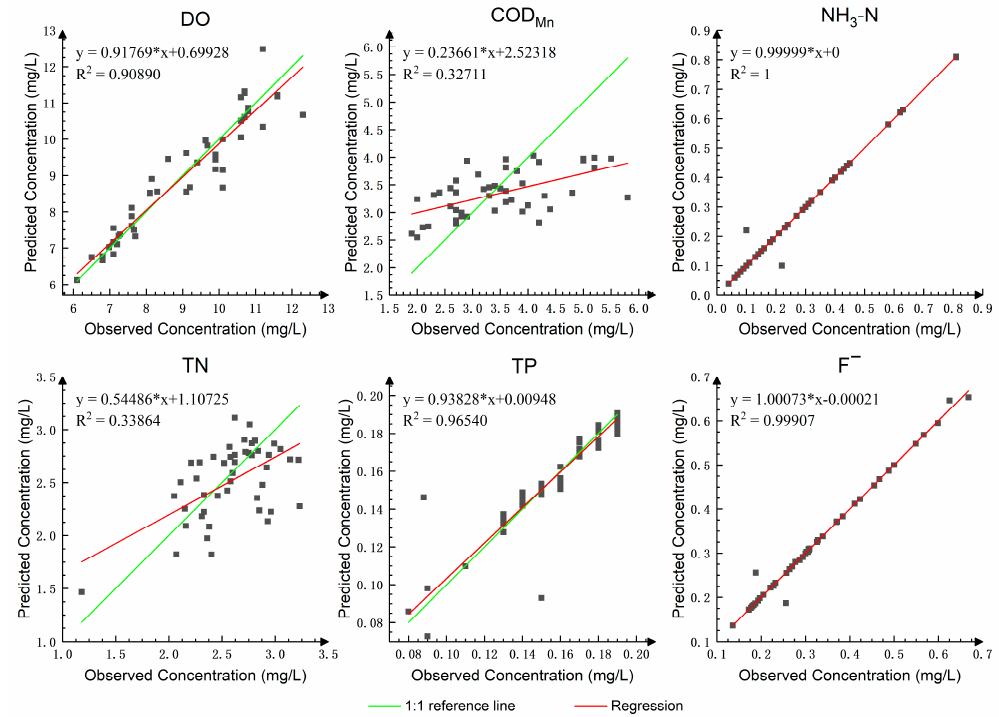
Figure 7. Downstream fitting comparison diagram of observed and predicted concentrations. Green line is the 1:1 reference line and red line is the regression line.